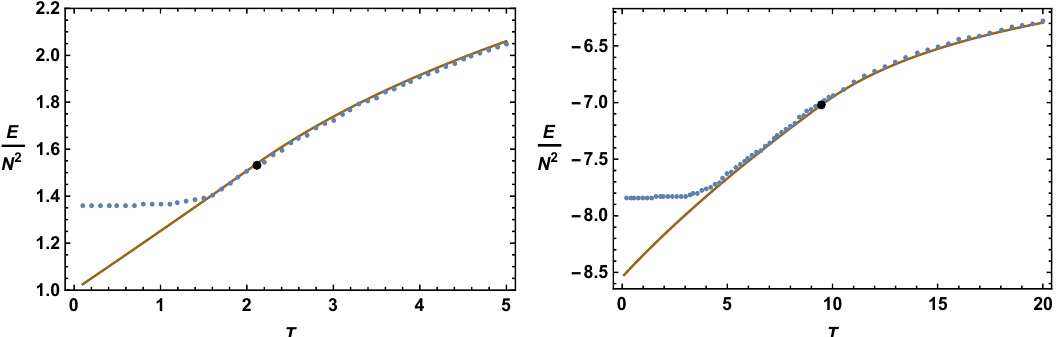
Figure 1: Large N energy density of two matrix Ising models as a function of tem- perature computed by numerical Monte Carlo simulation of spins (blue dots) and analytically from the corresponding matrix model (brown curve). The left plot has (cid:2) ( (cid:3) H = tr SS T ) 3 and the right plot has H = − 3tr dot indicates the location of the topological transition, which is above the glassy transition in both